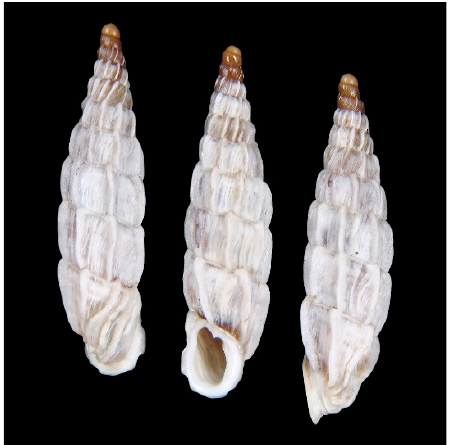
Figure 2. Albinaria adrianae. Courtesy of Guido T. Poppe and Philippe Poppe.